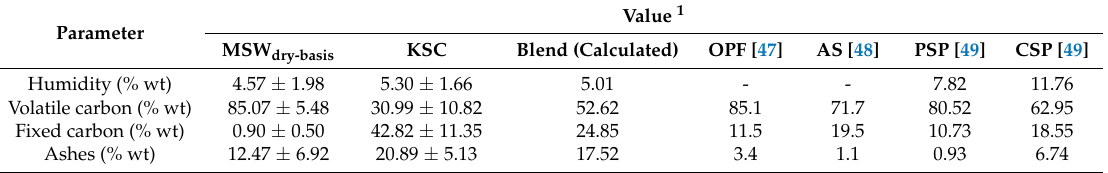
Table 6. Proximate analysis results for MSW and kernel shell charcoal (dry-basis).